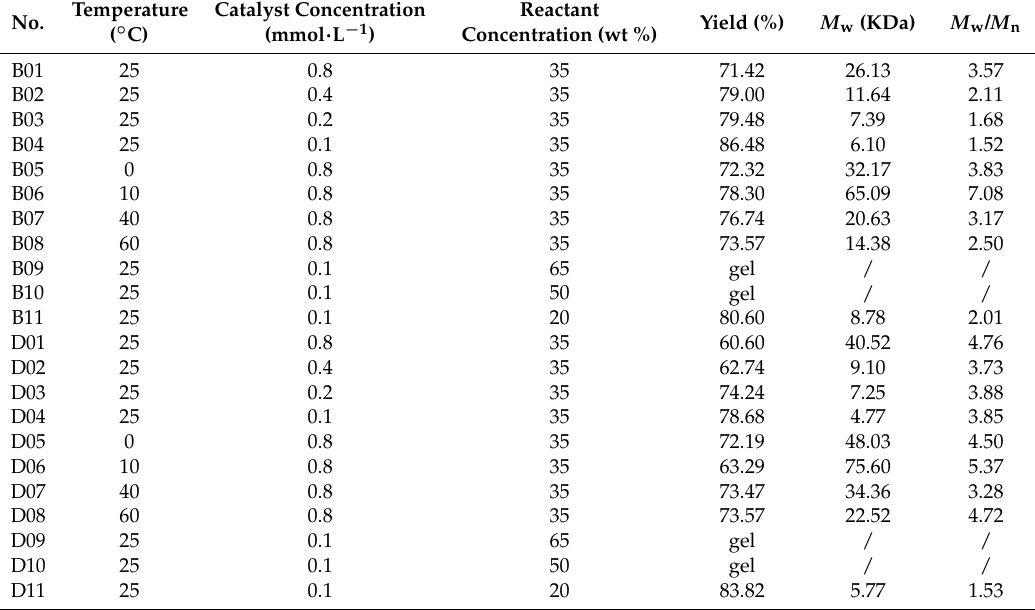
Table 1. Specific reaction conditions and gel permeation chromatography (GPC) data of polycondensation of diphenyldialkoxysilane with hydrogen-containing siloxanes (HCS) in toluene.